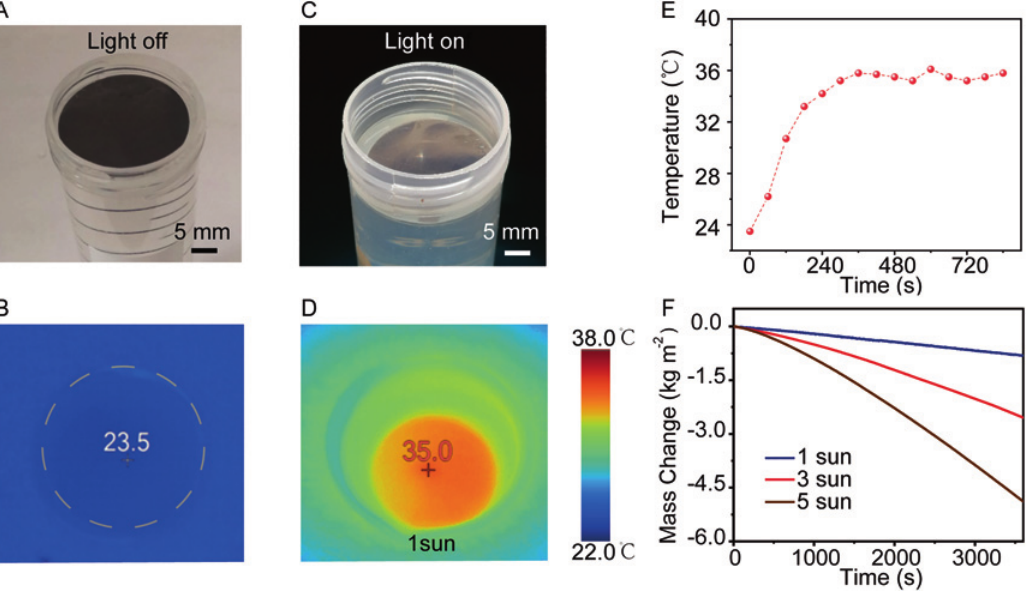
Figure 4: (A – D) Optical (A, C) and thermal images (B, D) of the Ni NP/AAO absorber floating on water before (A, B) and after (C, D) solar illumination, respectively. (E) Measured solar vapor temperature as a function of evaporation time. (F) Mass change curves as a function of evaporation time under different illumination intensity. The ambient temperature is ∼ 23 ° C and the humidity is ∼